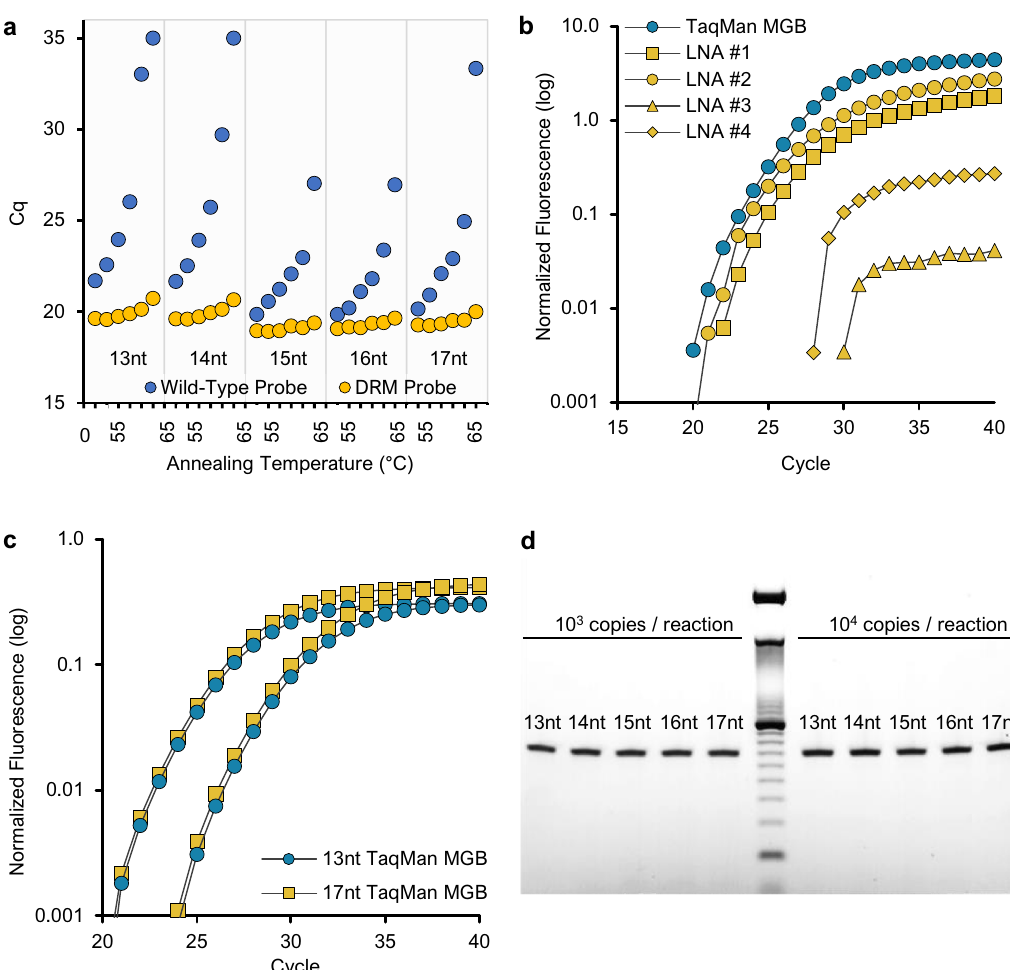
Fig. 2 Optimization of PANDAA probe design. a 13 – 17-nt TaqMan-MGB probes for 103 wild-type and DRM codons. Sensitivity and speci fi city were evaluated using a 55 – 65 °C annealing temperature gradient. Although predicted T m values ranged from 59 to 63 °C, there was little impact sensitivity with the AAC probes (yellow circles) for any probe length as the annealing temperature increased; however, non-speci fi c hybridization of the AAA probe (blue circles) to the mismatched AAC template was reduced as annealing temperature increased. b The performance of four 5 ′ hydrolysis probes with various placement of LNA nucleotides (yellow) was compared to a TaqMan-MGB probe (blue) of the same length. LNAs were found to have comparable performance to MGB probes although LNA nucleotide placement also had to be determined empirically. c Increasing probe length did not reduce sensitivity, as 13-nt probes (blue circles) had similar Cq values to 17-nt probes (yellow) at 10 4 and 10 3 copies per reaction. d To con fi rm that ampli fi cation ef fi ciency was not proportionally inhibited as the number of overlapping nucleotides increased, PANDAA reactions utilizing 13 – 17-nt probes were resolved on a 4% agarose gel, demonstrating comparable band intensities of a 66-bp amplicon across all probe lengths at both 10 3 and 10 4 DNA copies per reaction (middle lane: 10-bp DNA ladder). Furthermore, no non-speci fi c products were